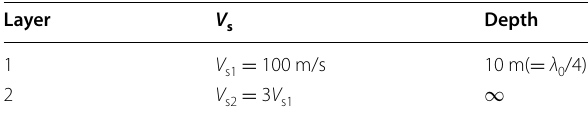
Table 1 Target two‑layered medium ( V sity 2.0 g/cm 3 ) =